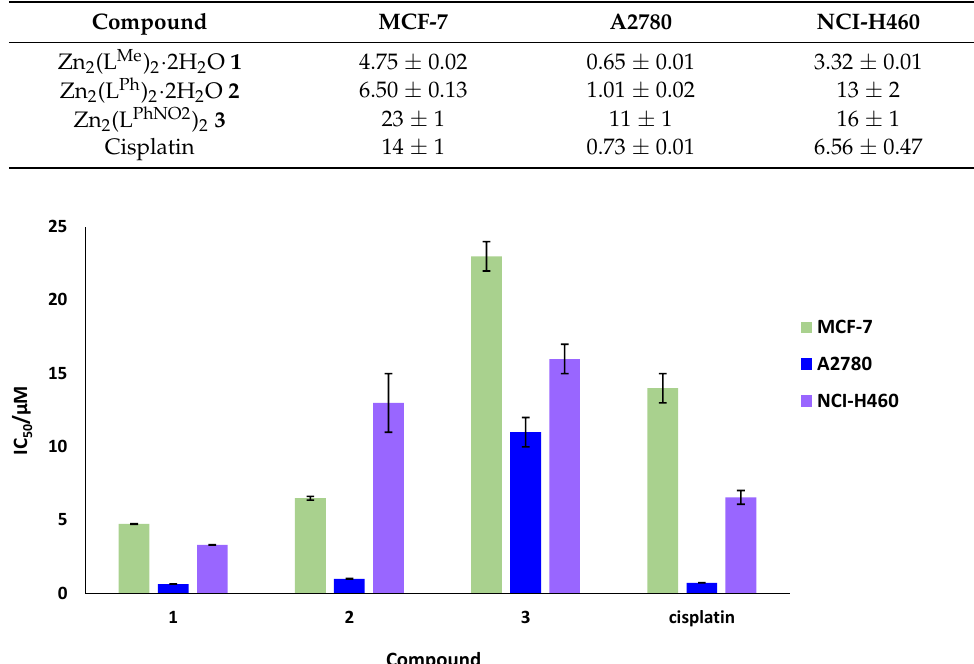
Table 1. IC 50 values for MCF-7, A2780 and NCI-H460 cancer cell lines after incubation 48 h at 37 °C and 5% CO 2 atmosphere, with zinc helicates in comparison to cisplatin.